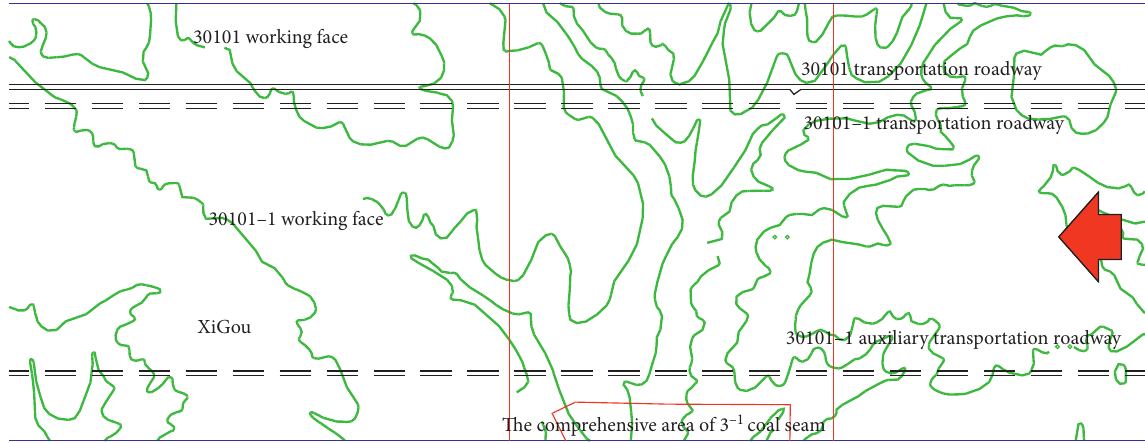
Figure 1: Comparison on surface and underground 30101-1 working face of Nanliang Coal Mine.